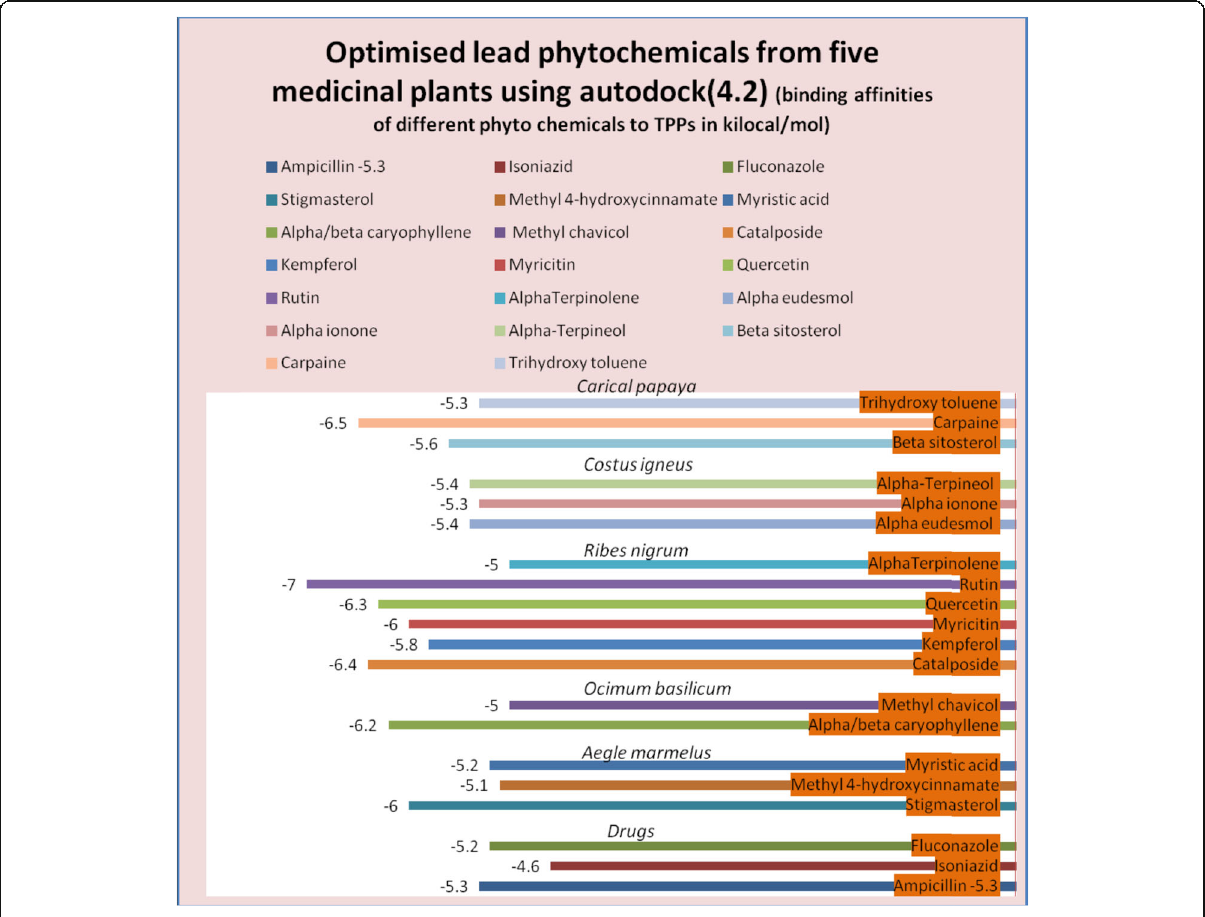
Fig. 4 Results of docking using AutoDock Vina 4.2